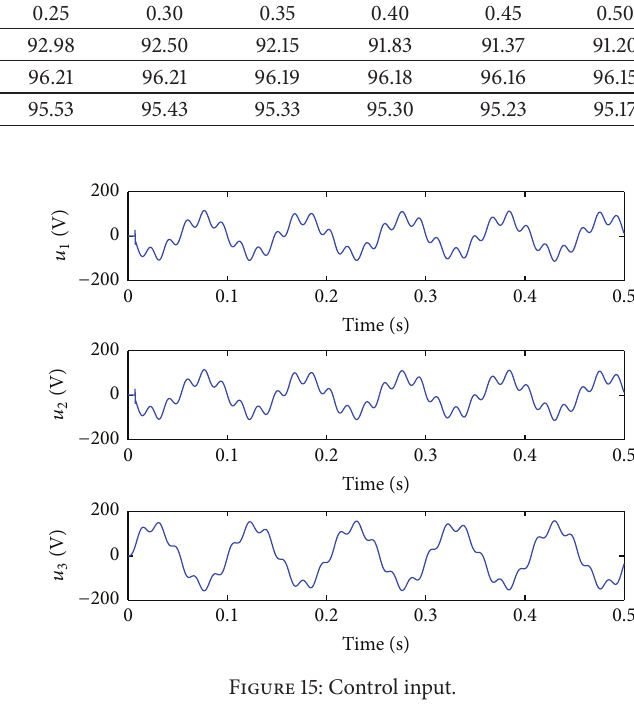
Table 10: 𝑦 -direction vibration attenuation ratio of nodes 19, 22, and 25 with different power-band white noise. Noise power